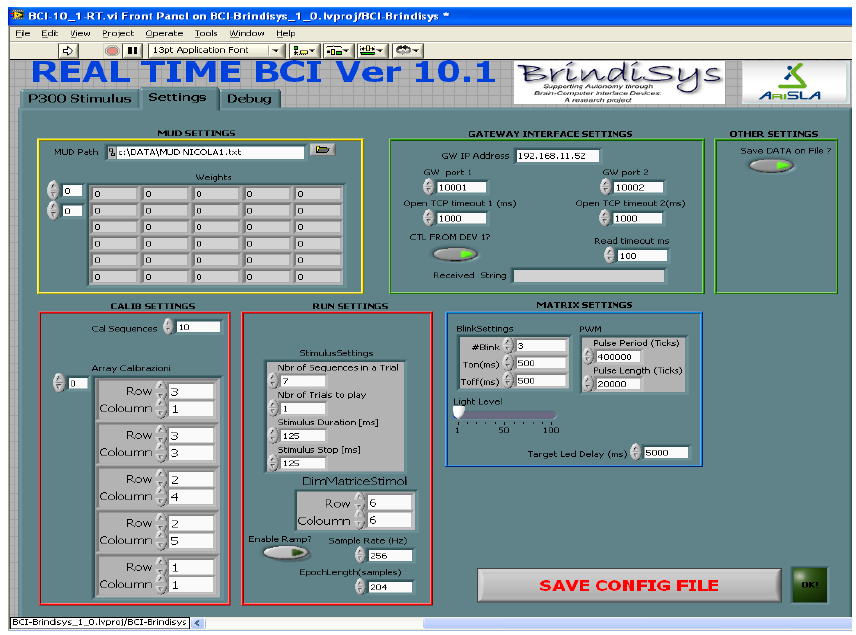
Figure 9. Operator interface of FPGA-embedded BCI that allows the configuration of the system.